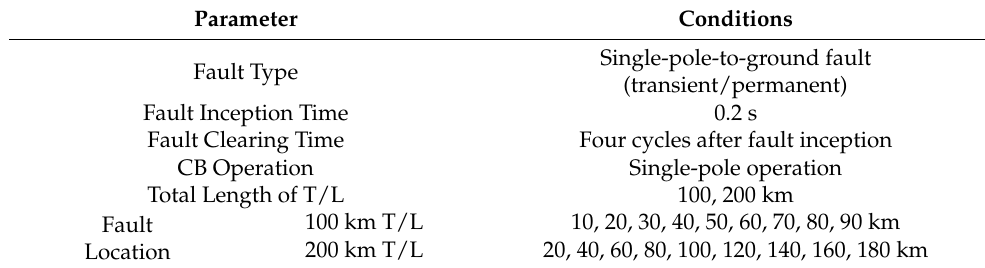
Table 2. Simulation conditions.